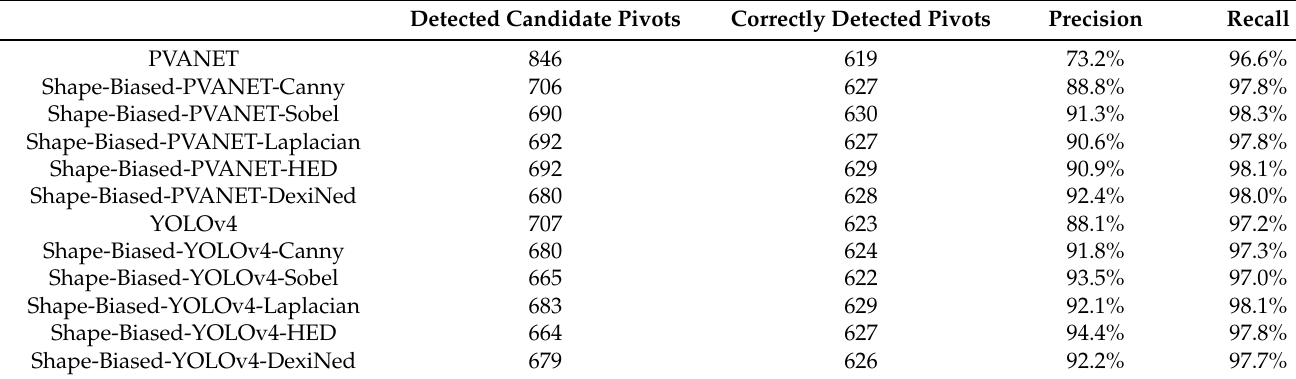
Table 3. The results of PVANET and YOLOv4 with edge image samples extracted using different methods in the training data.